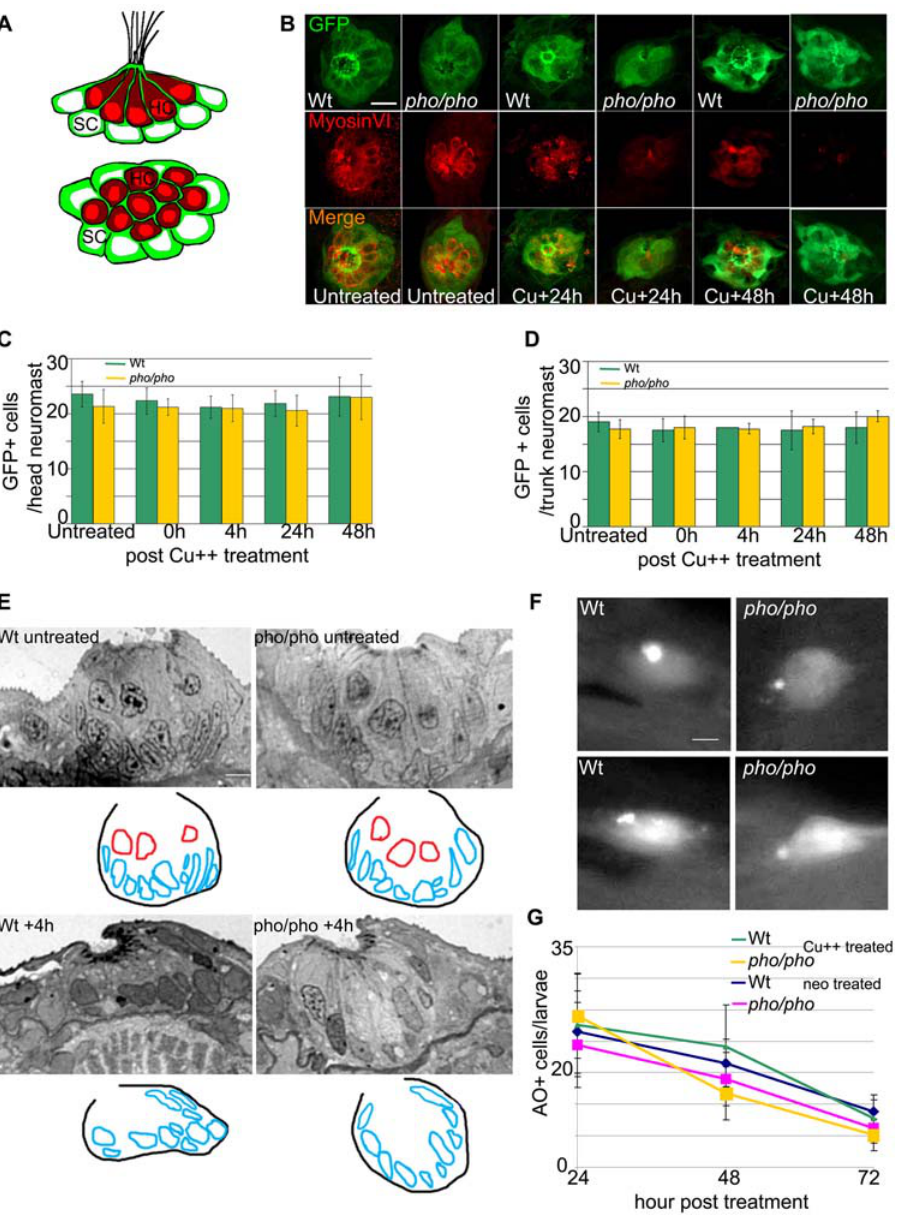
Figure 4. Supporting cells are present and do not die at a higher rate because of the treatments in the phoenix mutant neuromasts. (A) Schematic drawings of a side view (top panel) and a dorsal view (bottom panel) of a neuromast, illustrating the distribution of the two cell types. The hair cells (red) are centrally located and engulfed in a thin cytoplasmic furrow projected apically by the underlying supporting cells (green). (B) Immuno-labeled neuromasts with an antibody against GFP (top panels) staining the supporting cells and an antibody against Myosin VI (middle panels) staining the hair cells. Merged images are presented in the bottom panels. The SCM1 transgenic line, which we crossed into the phoenix mutant background, is expressing GFP exclusively in the supporting cells of the lateral line. We imaged transgenic wild-type (from the left, columns 1, 3, and 5) and transgenic phoenix mutant (columns 2, 4, and 6) larvae. Columns 1 and 2 are untreated 5dpf larvae. Columns 3 and 4 are larvae 24h post copper treatment. Columns 5 and 6 are larvae 48h post copper treatment. (C) Quantification of the number of GFP positive supporting cells respectively, in untreated (n=18/21) and in + 0h (n=12/9), + 4h (n=15/17), + 24h (n=15/12), and + 48h (n=15/18) post copper treated transgenic wild-type (green bars) and transgenic phoenix mutant (yellow bars) head neuromasts. (D) Trunk neuromasts in wild-type and phoenix mutant transgenic larvae have been counted at the same stages, respectively untreated (n=3/4), + 0h (n=4/3), + 4h (n=1/4), + 24h (n=2/5), and + 48h (n=2/ 3). (E) Semi-thin sections through wild-type (left panels) and mutant (right panels) neuromasts in untreated (top panels) and + 4h post neomycin treated (lower panel) 5dpf larvae. We used between 13 and 20 successive sections to reconstruct each wild-type and mutant neuromast (n=1/2 untreated, n=6/6 at + 4h, respectively). We show one representative wild-type and mutant section at each stage. Under each section, a camera lucida sketch is showing the limits of the neuromast and the outlines of the nuclei (red for hair cells, blue for supporting cells). (F) Live images of two wild- type (left panels) and two mutant (right panels) neuromasts after AO stainings in larvae, 24h post copper treatment. (G) Scoring of the number of acridine orange (AO) positive cells in the lateral line/larvae, 24, 48, and 72h post copper (Cu ++ ) or neomycin (neo) treatments. For the copper treatment, we monitored wild-type (green line) and mutant (yellow line, n=22/13 at + 24h, n=14/12 at + 48h, and n=18/6 at + 72h, respectively) larvae. For the neomycin treatment, we monitored wild-type (blue line) and mutant (pink line, n=12/10 at + 24h, n=11/14 at + 48h, and n=10/11 at + 72h, respectively) larvae. – 10 microns in (B) and (F) and 5 microns in (E).